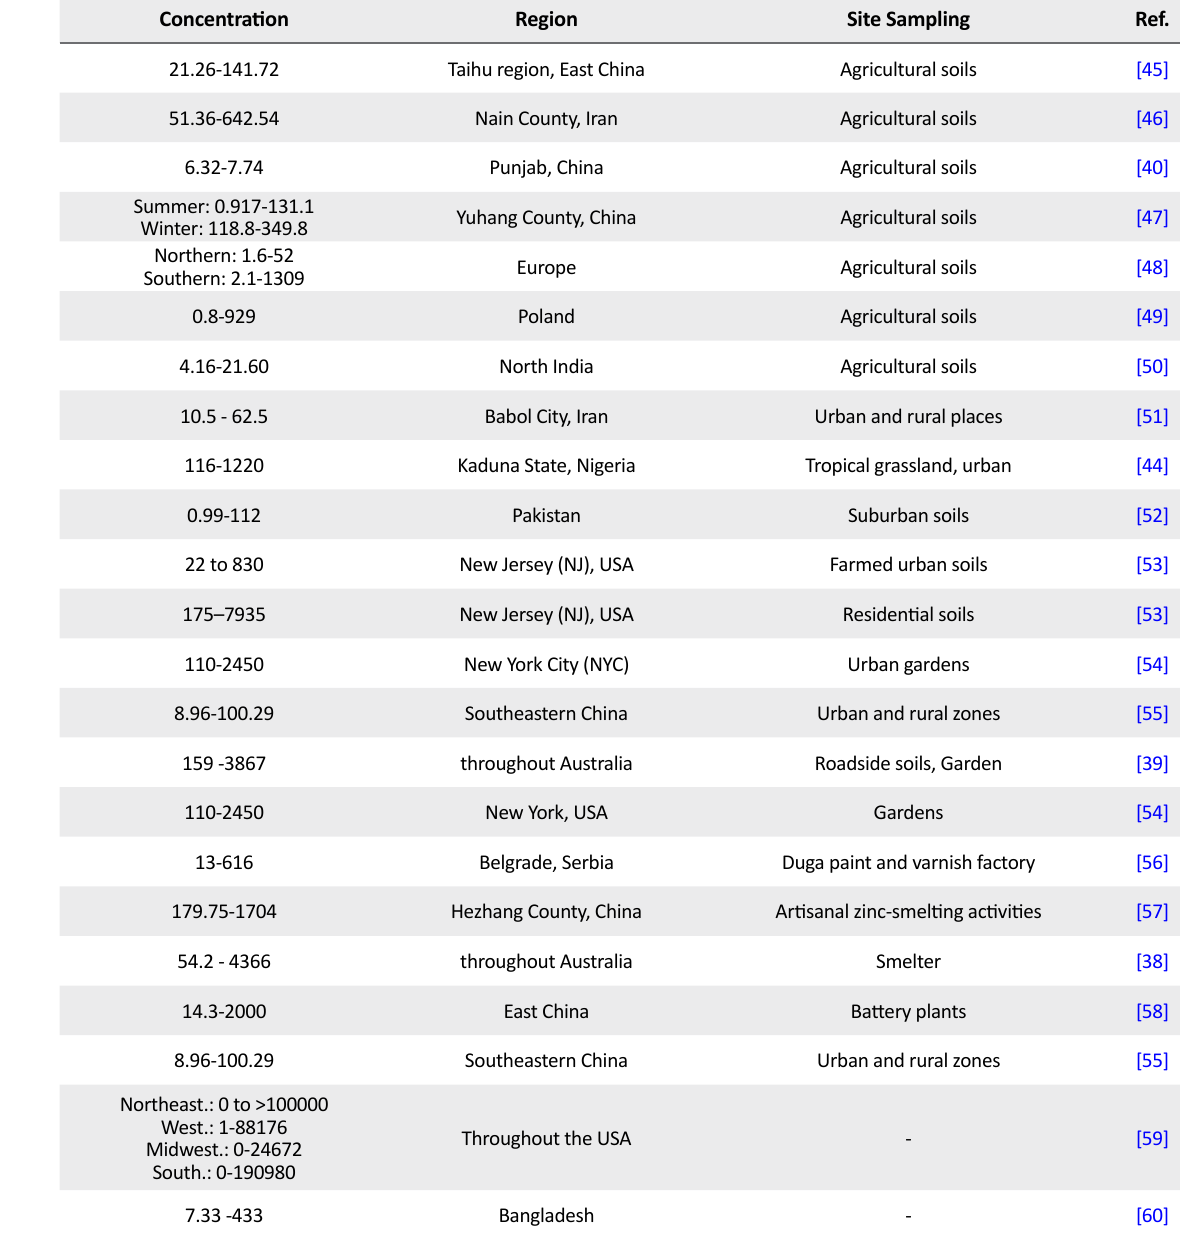
Table 2. Lead (Pb) concentration (mg/kg) in soil from different countries Concentration Region Site Sampling